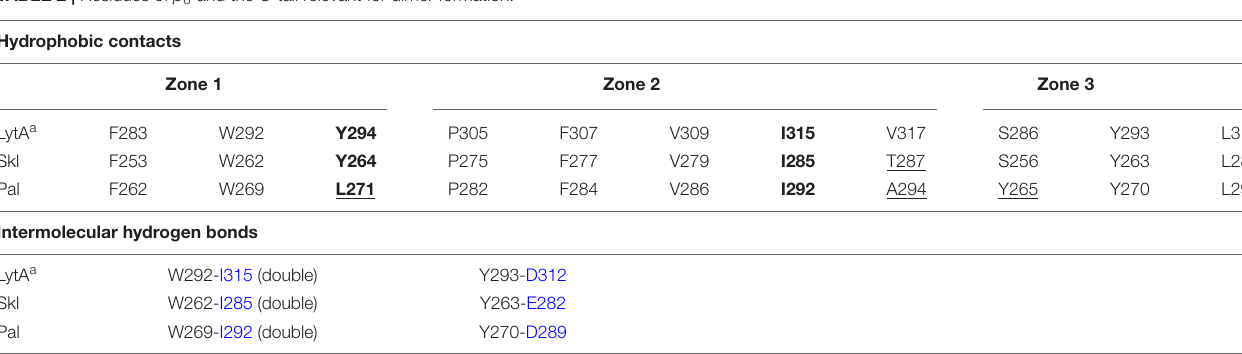
TABLE 2 | Residues of p 6 and the C-tail relevant for dimer